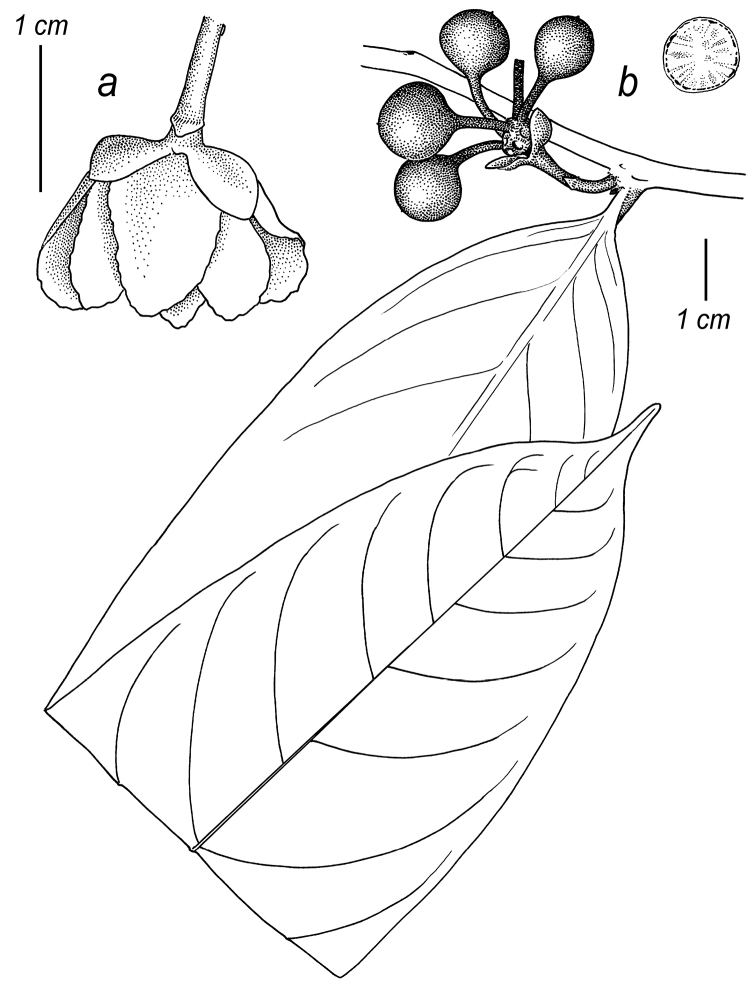
Cremastospermamagdalenae Pirie. a flower b fruiting twig and cross section of seed (aHernandez 251bEscobar & Folsom 3309).